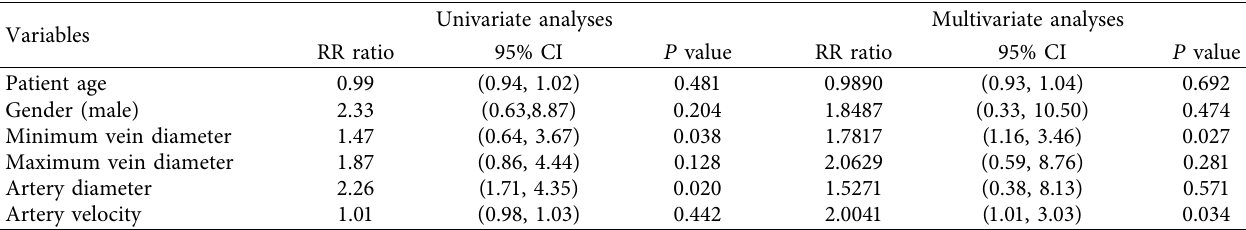
Table 5: Univariate and multivariate analyses between demographics and vessel measurements on RCF outcomes.